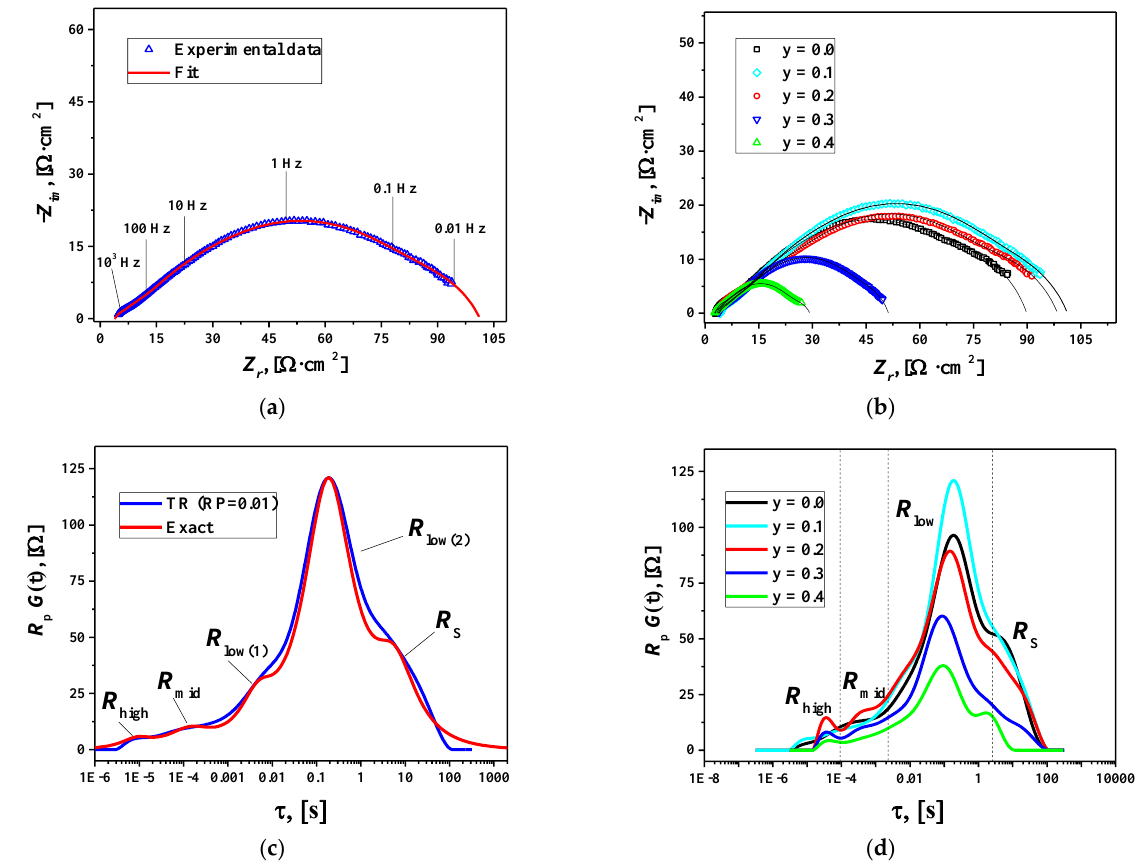
( d ) Figure 8. Fitted impedance spectra at 600 °C for the symmetrical cells: ( a ) Figure 8. Fitted impedance spectra at 600 ◦ C for the symmetrical cells: ( a ) La 1.7 Ca 0.3 Ni 0.9 Cu 0.1 O 4+ δ / La 1.7 Ca 0.3 Ni 0.9 Cu 0.1 O 4+δ /SDC, and ( b ) La 1.7 Ca 0.3 Ni 1−y Cu y O 4+δ /SDC; DFRTs at 600 °C for the symmetrical SDC and ( b ) La 1.7 Ca 0.3 Ni 1 − y Cu y O 4+ δ /SDC; DFRTs at 600 ◦ C for the symmetrical cells; cells; ( c ) La 1.7 Ca 0.3 Ni 0.9 Cu 0.1 O 4+δ /SDC, and ( d ) La 1.7 Ca 0.3 Ni 1−y Cu y O 4+δ /SDC. ( c ) La 1.7 Ca 0.3 Ni 0.9 Cu 0.1 O 4+ δ /SDC, and ( d ) La 1.7 Ca 0.3 Ni 1 − y Cu y O 4+ δ The distribution functions of relaxation times (DFRTs) for the obtained impedance data were calculated using Tikhonov regularization (TR) in DRTtools [50,51]. A Gaussian- type function and a regularization parameter (RP) of 0.01 were used for calculations. The obtained DFRTs are shown in Figure 8c,d. The curves demonstrate the presence of at least five contributions to the polarization resistance of the La 1.7 Ca 0.3 Ni 1−y Cu y O 4+δ /SDC cells. One can observe two relatively small peaks at high ( R high ) and middle ( R mid ) frequencies and three significantly larger overlapping peaks at low frequencies ( R low(1) , R low(2) , and R S ), which show that low-frequency processes dominate the polarization resistance of the studied cells. The R low(1) and R low(2) peaks merge into one peak ( R low ) at T > 650 °C. Conse- quently, the R low(1) and R low(2) resistances can be determined as distinct values only at lower temperatures (T = 600 °C). According to this, the equivalent circuit for fitting the imped- ance spectra consisted of ohmic resistance of the electrolyte R 0 and four (T ≥ 650 °C) or five (T = 600 °C) R-CPE elements connected in series. The R-CPE element, also known in the literature as ZARC, is a parallel combination of resistance and constant phase element. As an example, Figure 8a shows a satisfactory fit of the impedance spectrum for the La 1.7 Ca 0.3 Ni 0.9 Cu 0.1 O 4+δ /SDC cell at 600 °C. The obtained fitting parameters were used to